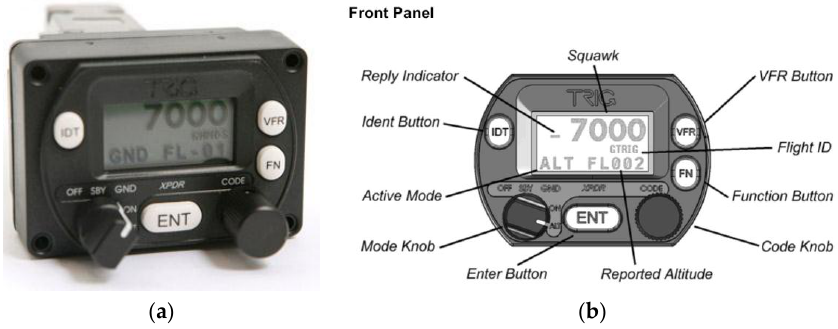
Figure 13. ( a ) Photograph of TT21 transponder; and ( b ) front panel of TT21 transponder.